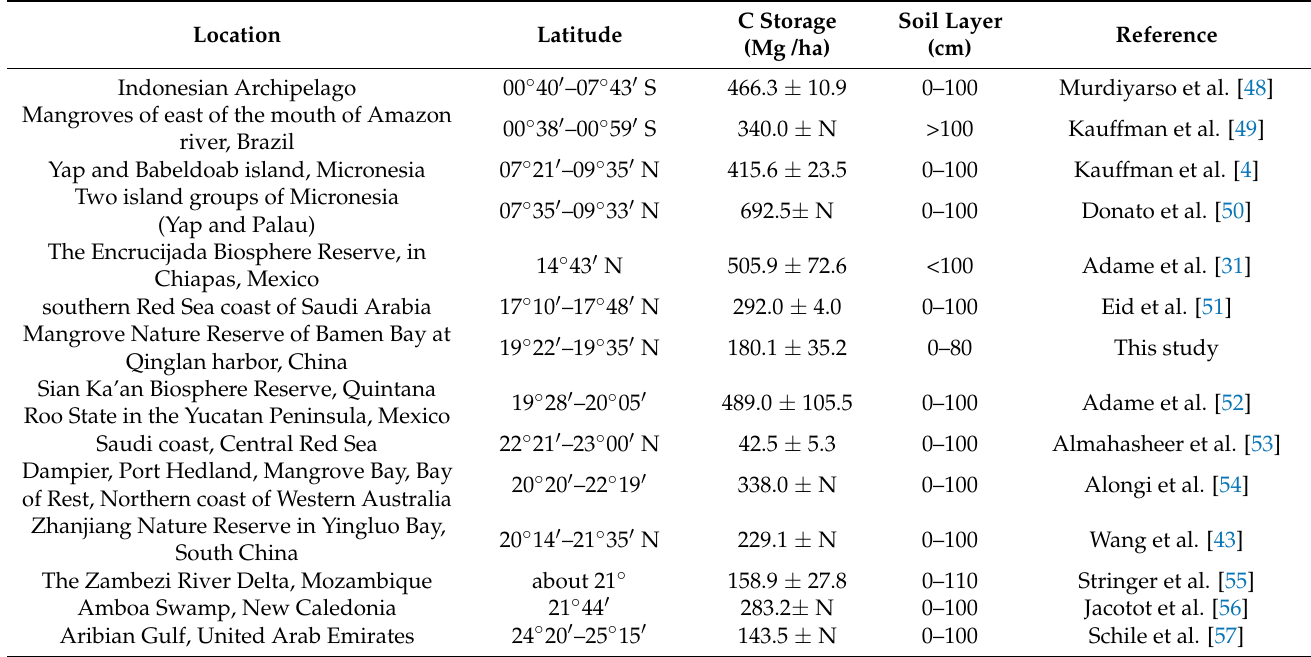
Table 3. Comparison of SOC storage at different sites (mean ± standard